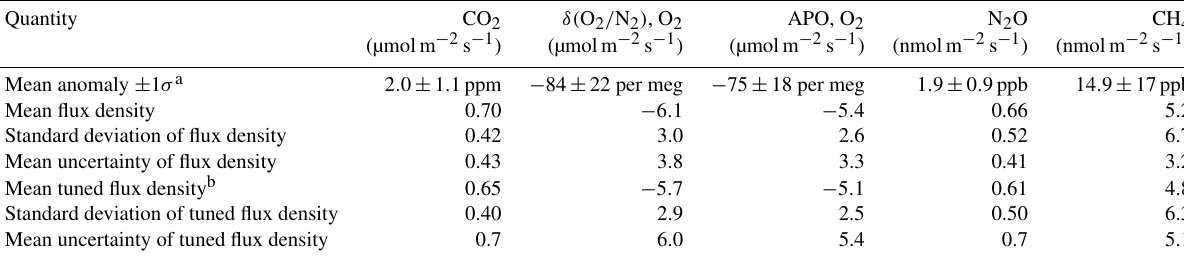
Table 1. Means of all atmospheric anomalies and top-down flux density estimates for identified upwelling events.